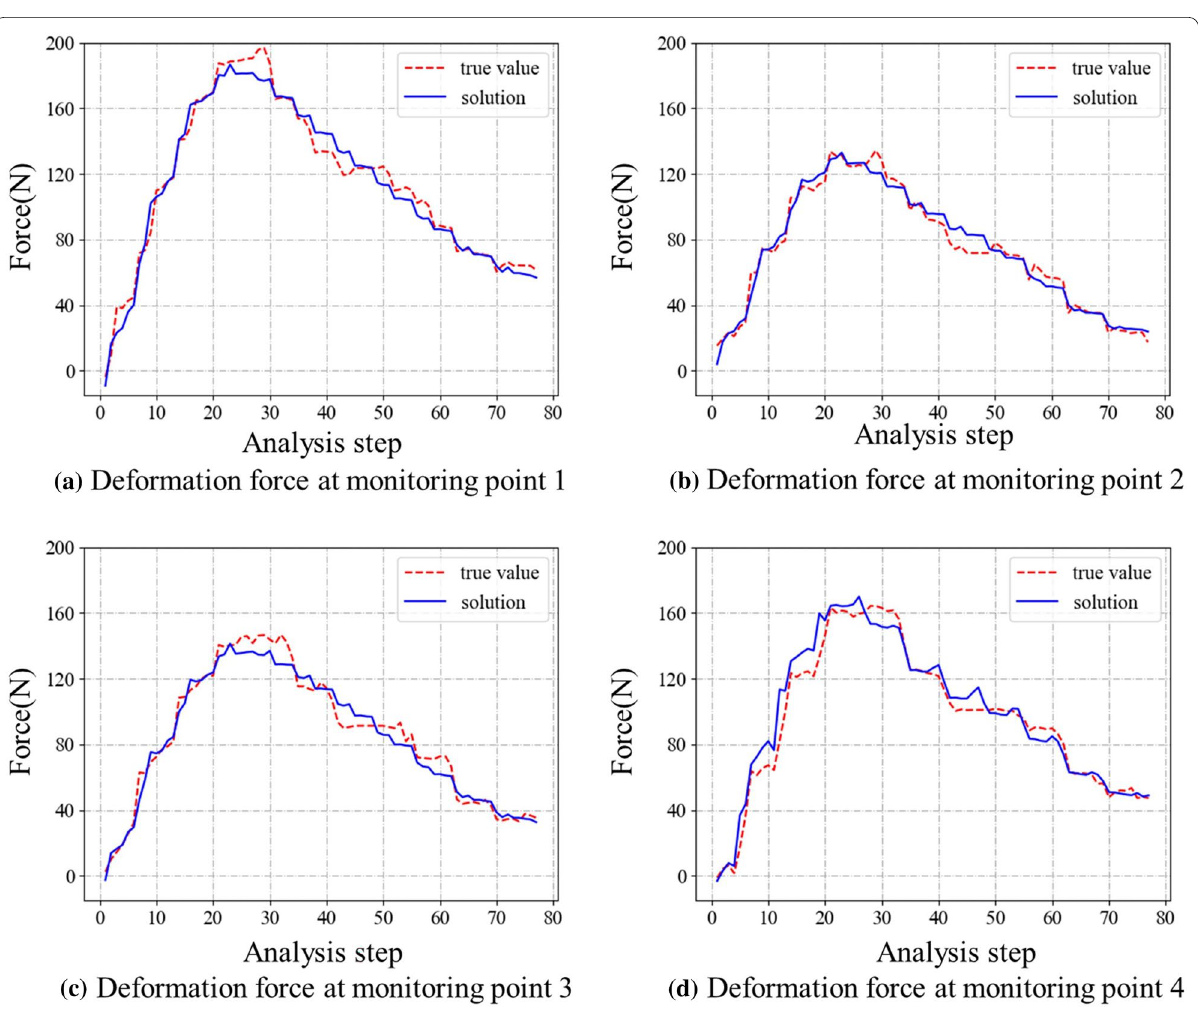
Figure 17 The comparison between the deformation force with a solution error of 7.2 N and the real monitored deformation